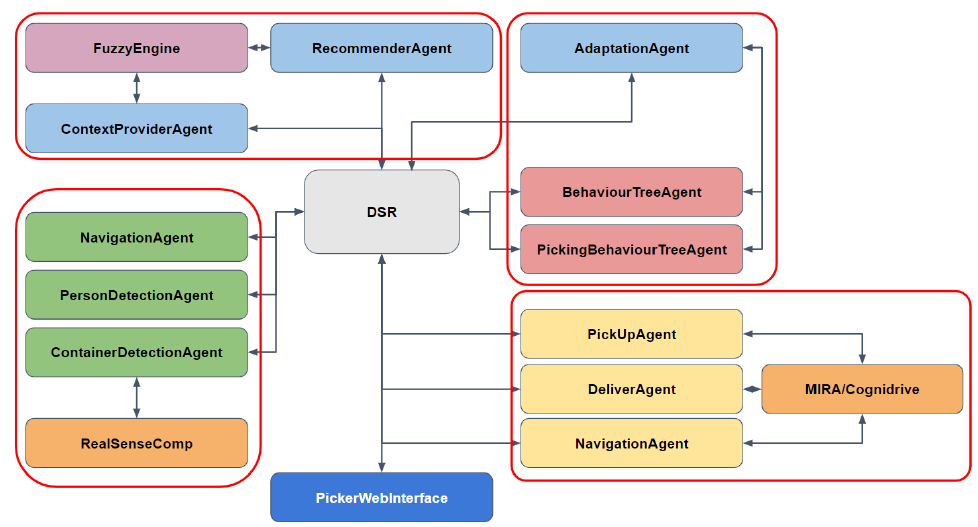
Figure 6. Software architecture for managing the CARY